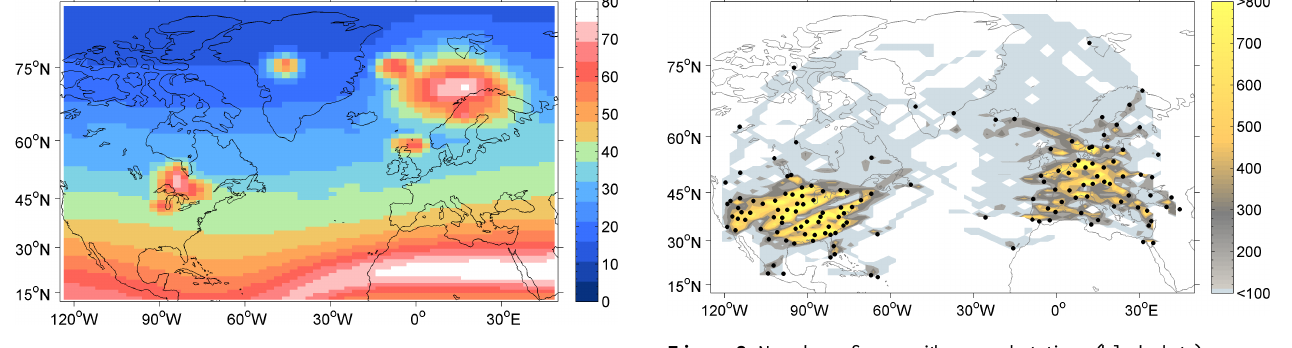
Figure 2. Simulated ionosphere with structures added to IRI2012. Values are in TECU (10 16 electronsperm − 2 ).